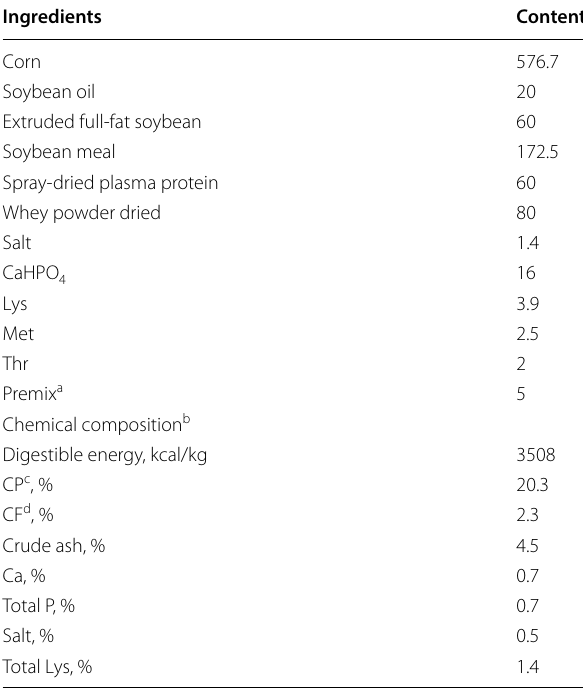
Table 1 Composition and nutrient levels of the basal diet (g/kg, as-fed